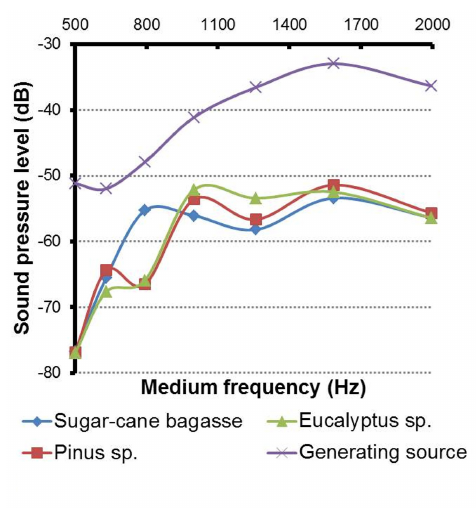
Figure 8. Sound pressure levels for medium frequencies (500 – 2,000 Hz).